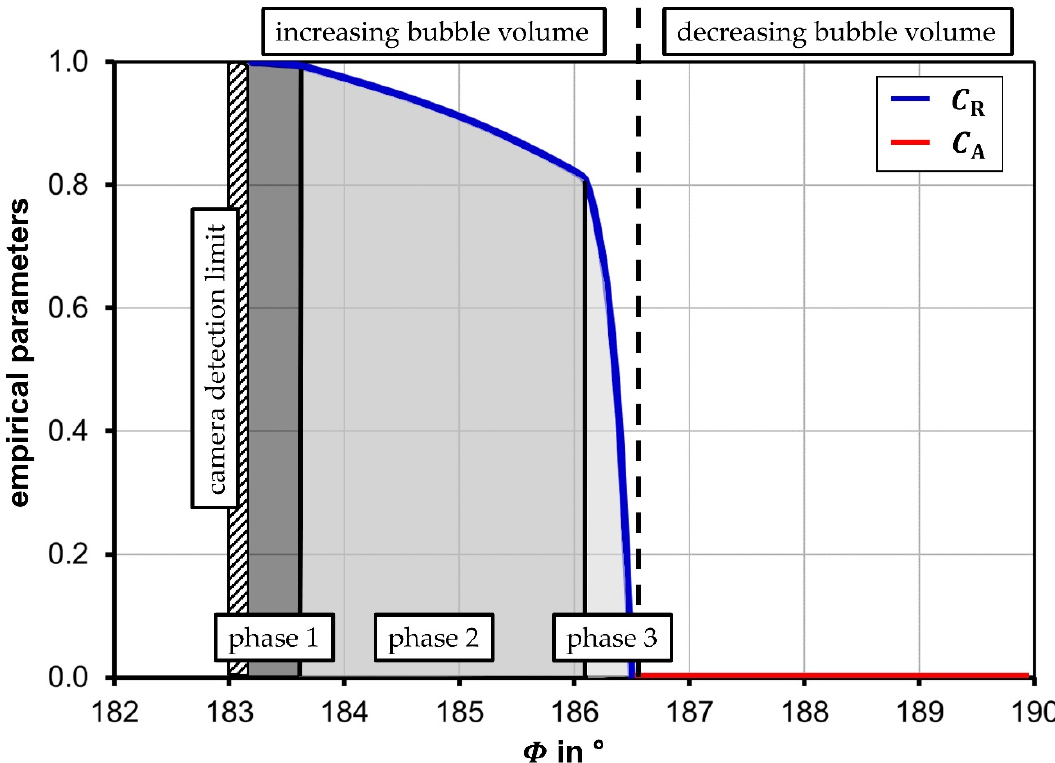
Figure 18. Empirical parameters according to Schneer–Sauer model for bubble growth (gas release) and bubble decrease (absorption) after initiation of transient radial displacement, fluid: paraffin containing 100% dissolved air.